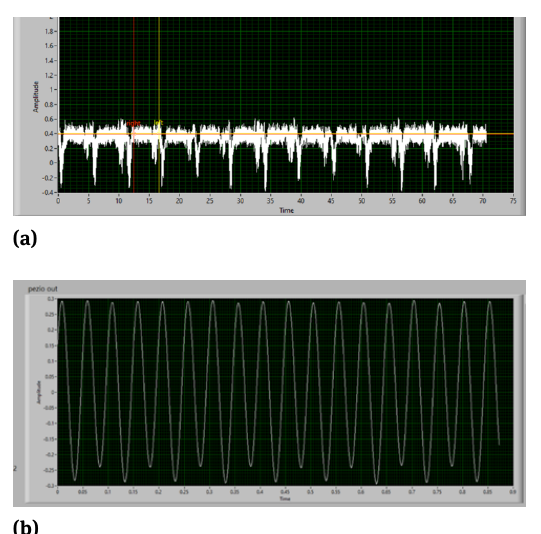
Table 4: The amplitude of the harmonic load ( 2 mew 2 0